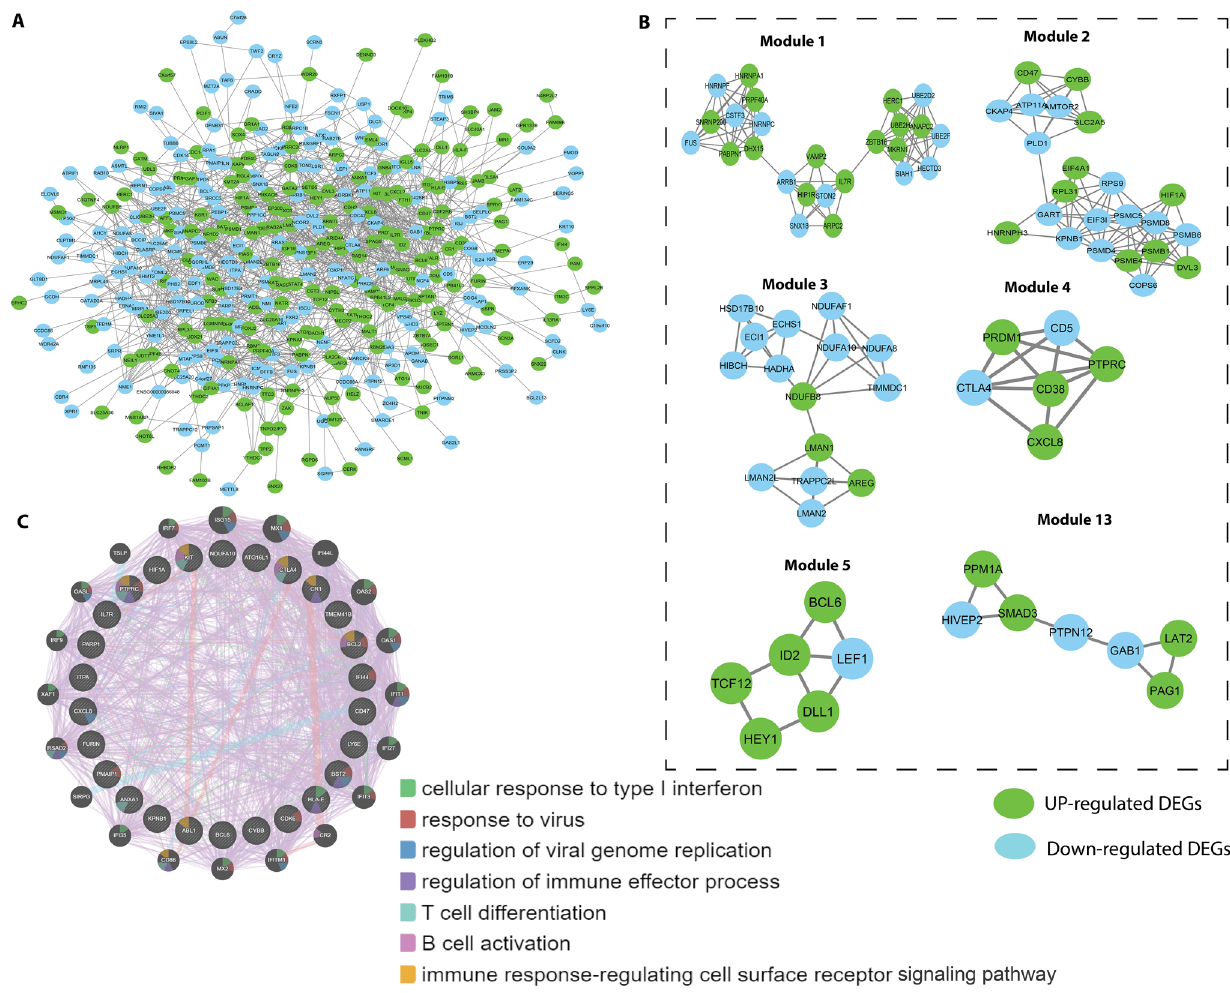
Fig. 5 Protein–protein interaction (PPI) network and hub cluster- ing modules. A The PPI network of overlapping DEGs. Green nodes represent up-regulated DEGs, and cyan nodes represented down- regulated DEGs. B Module 1 (MCODE score = 7.917), Module 2